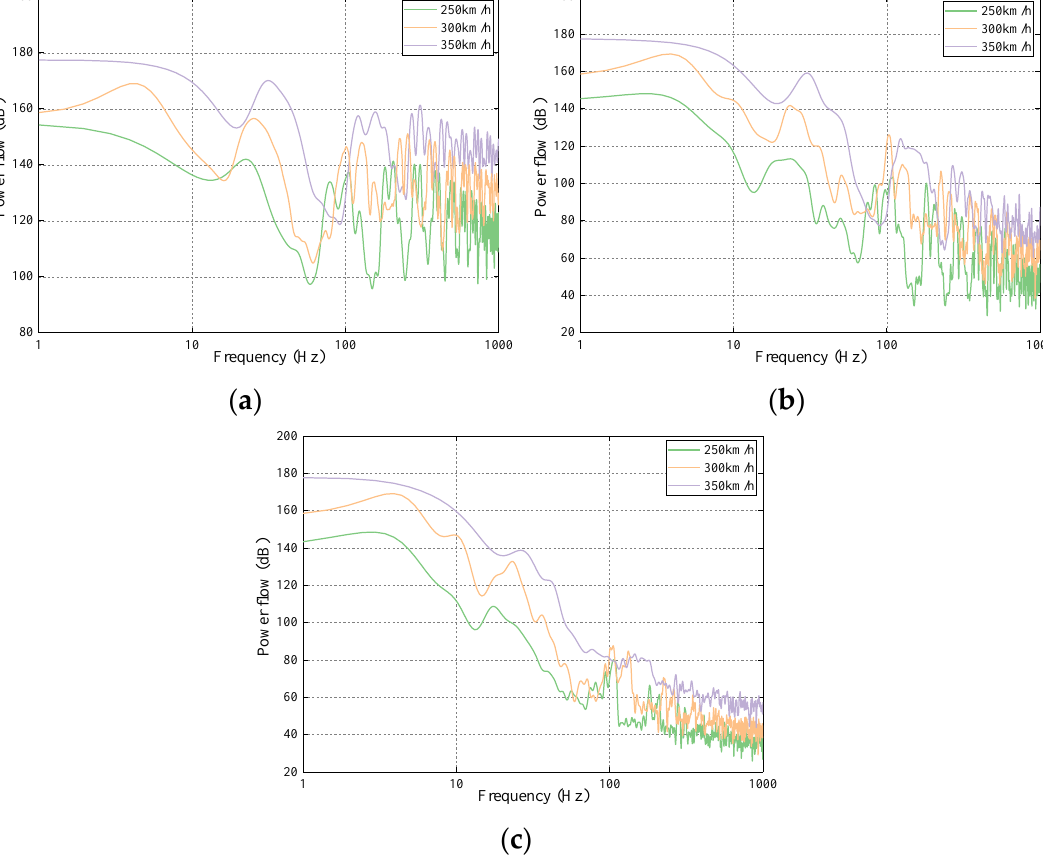
( b ) Figure 14. The PFTRs from ( a ) the rail to the slab track and ( b ) the slab track to the bridge.